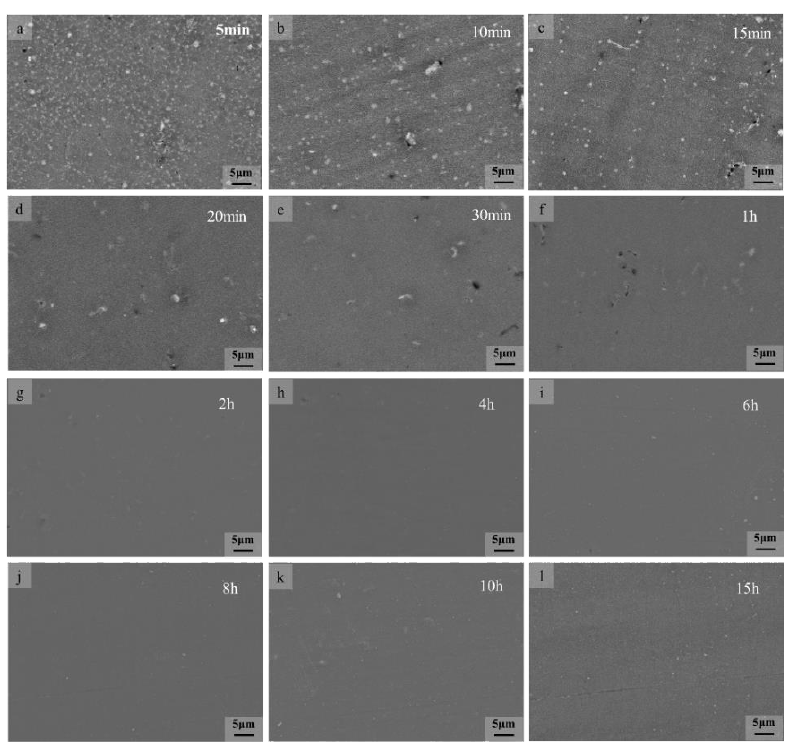
Figure 8. Dissolution of the β -Mg 17 Al 12 at 410 °C for different times.